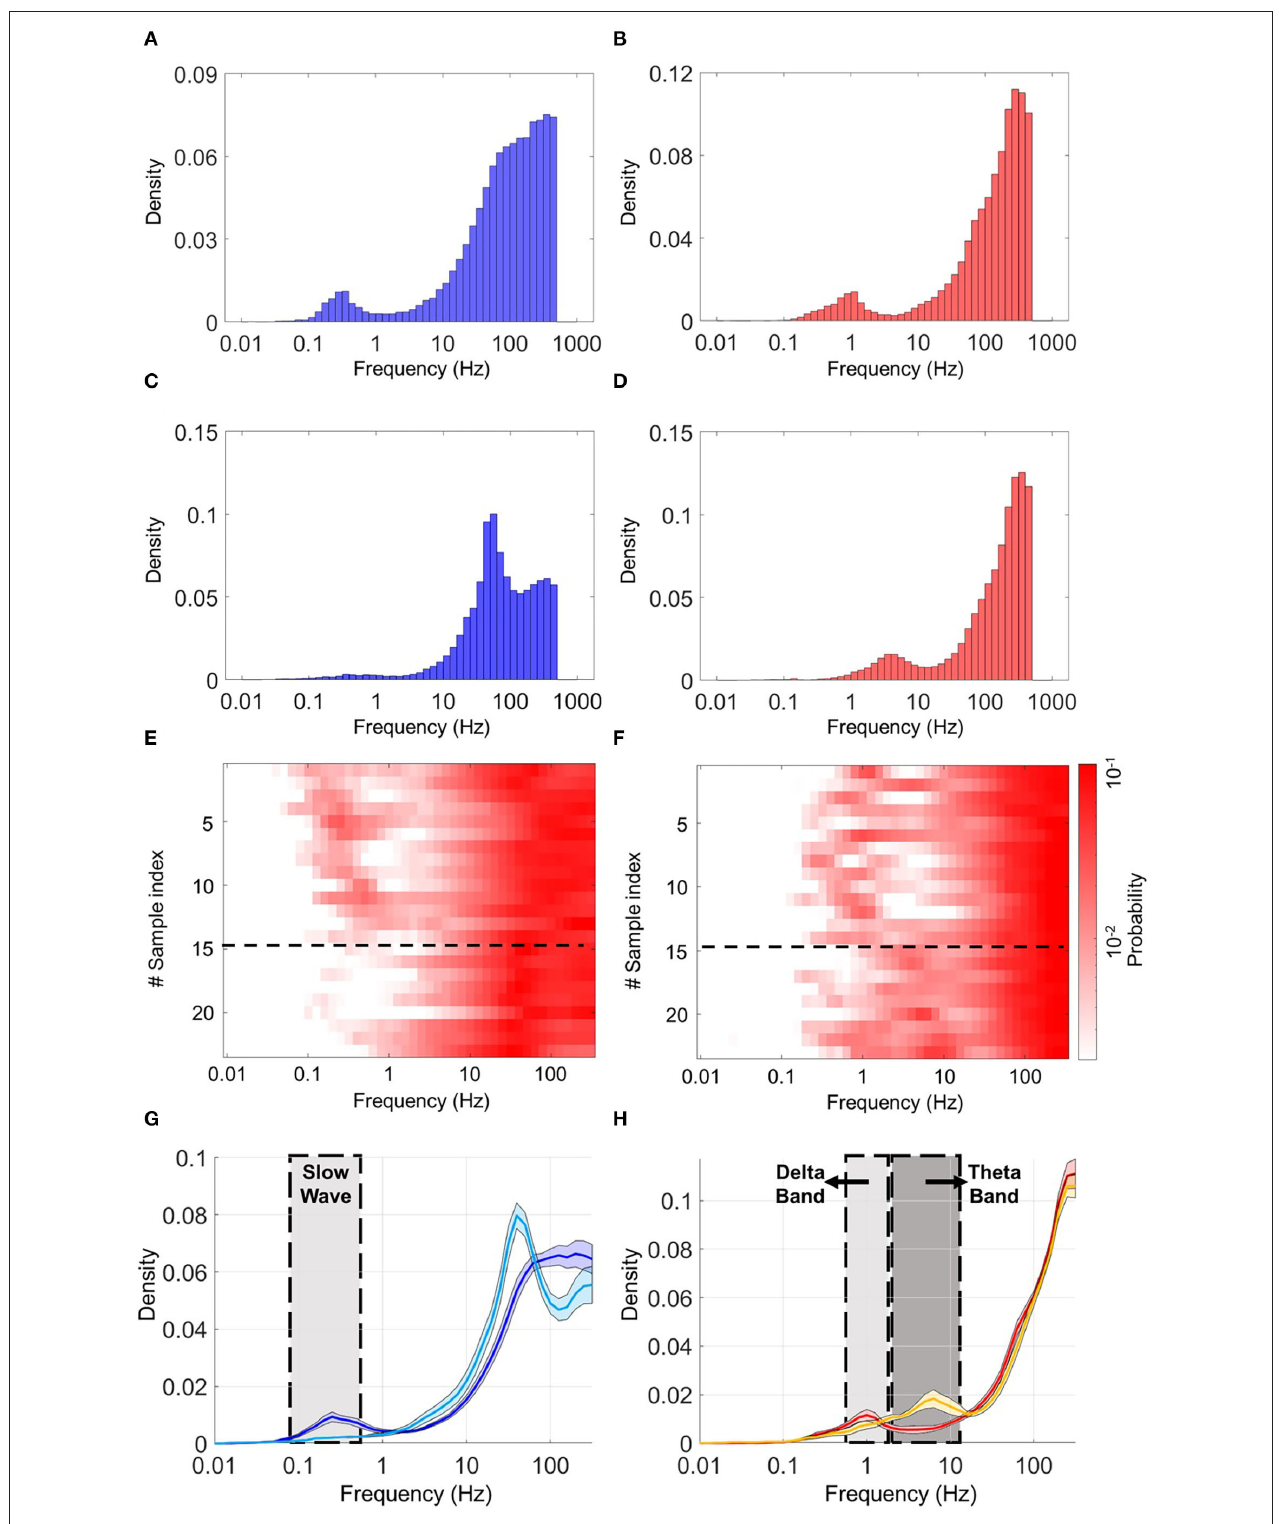
FIGURE 6 | Histograms of the inverted inter-spike interval (ISI) in heterogeneous cocultures. (A,C) are the histograms of the CX part, (B,D) are the histograms of the HPC part of two typical coculture samples. (A,B) Show a typical sample expressing slow-burst coupling. (C,D) show a typical sample expressing fast-burst coupling. The CX network in (A) shows two peaks, in the slow-wave and gamma-frequency bands, respectively. The CX network in (C) shows a single peak in the low-gamma